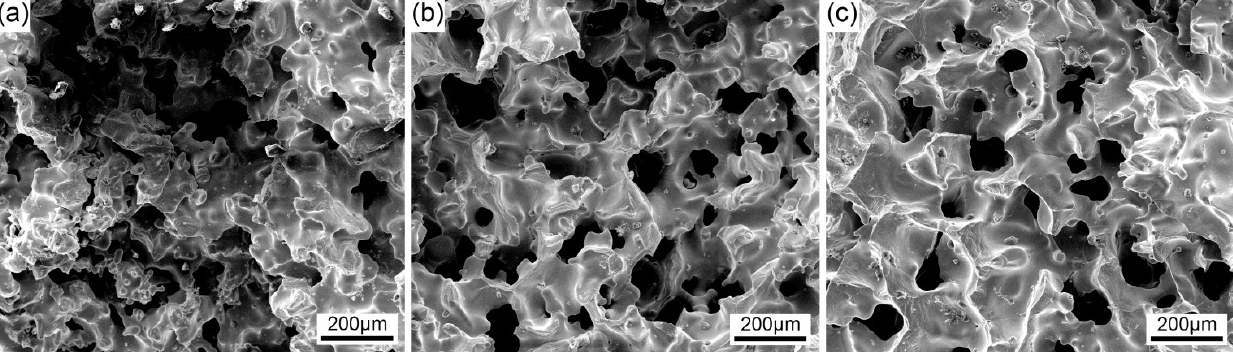
Figure 4. SEM of porous Cu bodies produced using different CuO contents: ( a ) 20 vol.%; ( b ) 30 vol.%; ( c ) 40 vol.%.